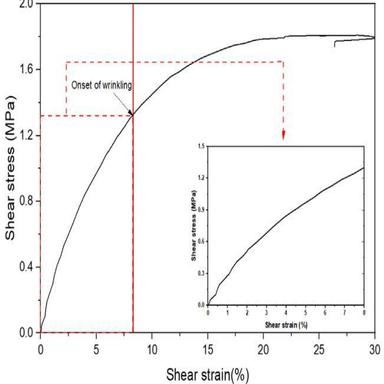
A representative shear stress vs shear strain curve during the test. (For interpretation of the references to colour in this figure legend, the reader is referred to the web version of this article.)